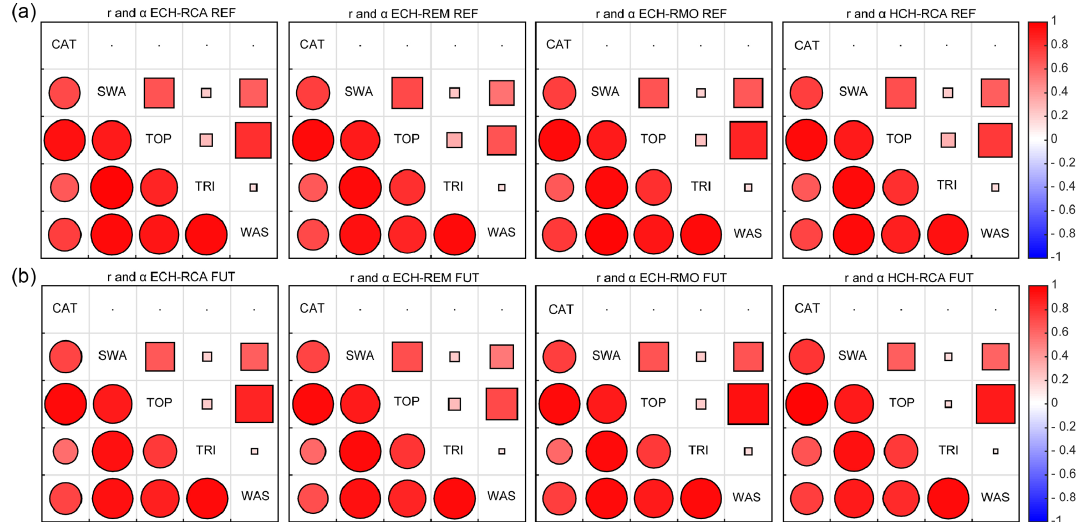
Figure 11. As Fig. 10, but for mean monthly soil water content agreement between the five hydrologic models (CAT: CATHY, SWA: SWAT, TOP: TOPKAPI, TRI: tRIBS, WAS: WASIM) for the reference (REF, a ) and future (FUT, b )